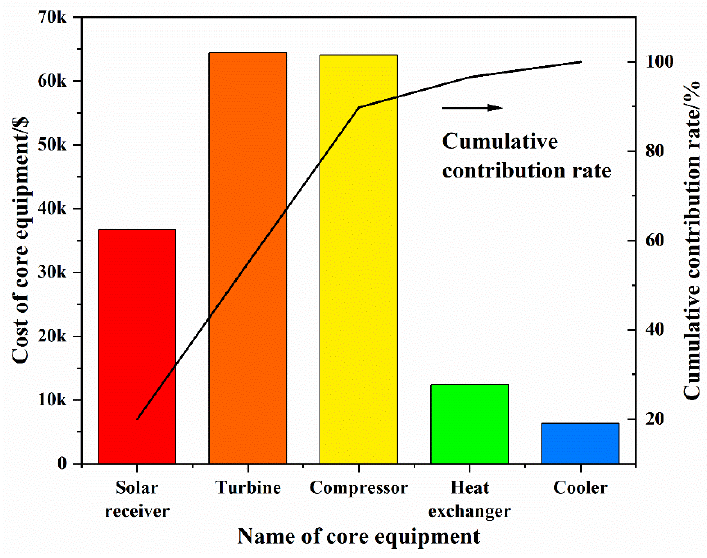
Figure 14. Comparison of core equipment cost.